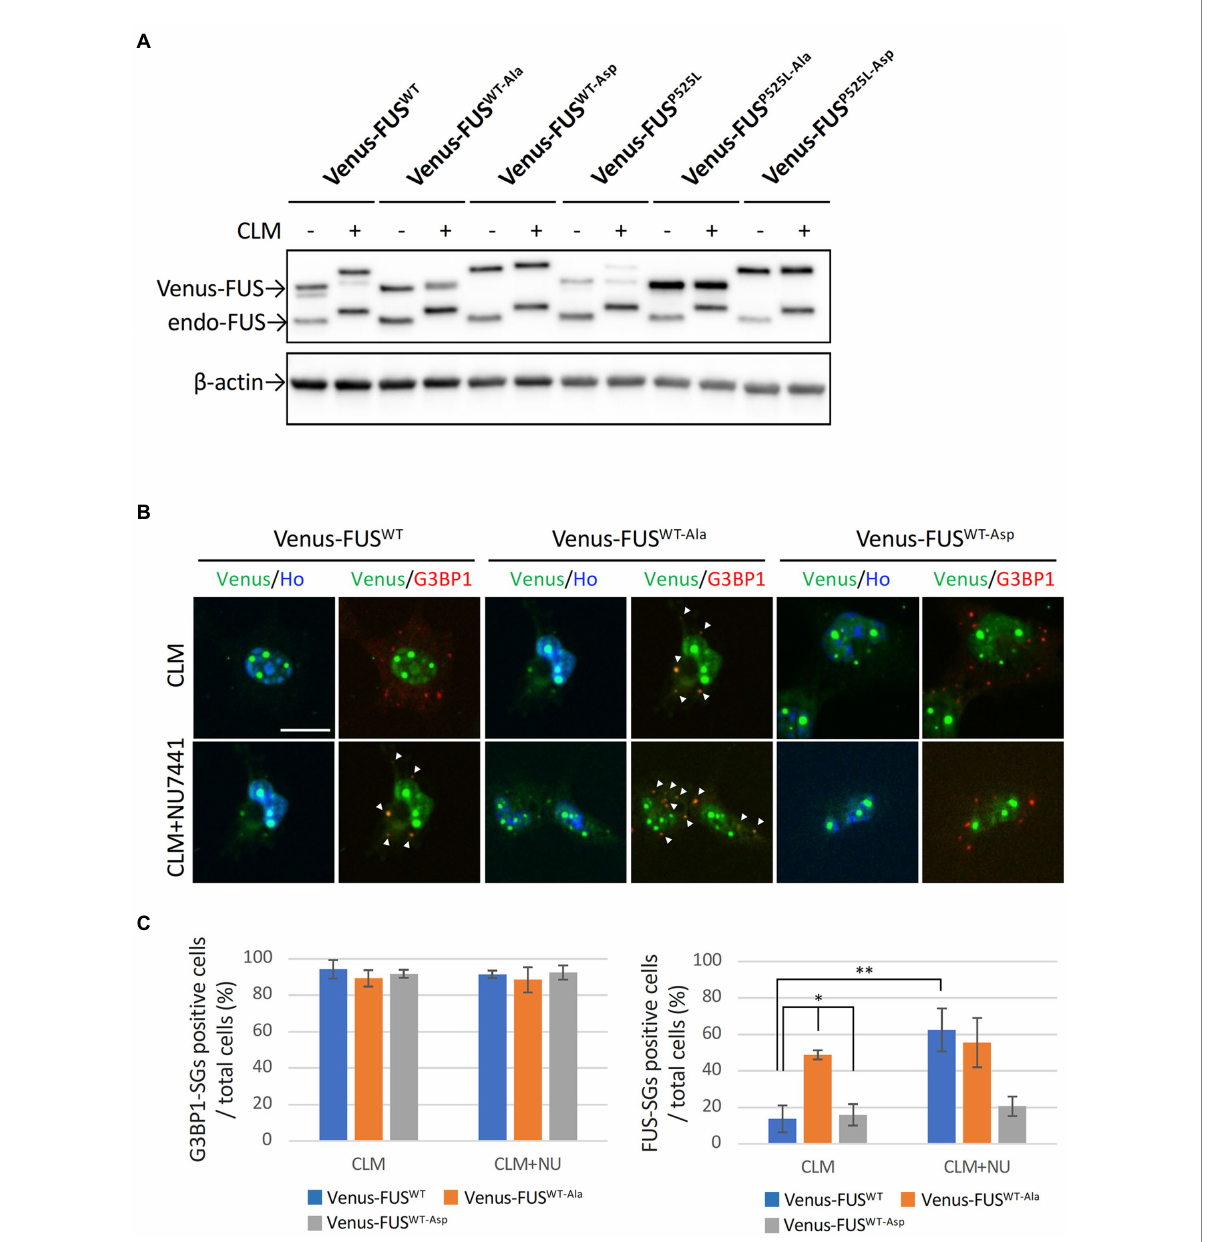
FIGURE 3 Effect of replacing 12 S/TQ residues with AQ or DQ residues in the N-terminal region of wild-type and mutant FUS proteins. (A) U251 MG (KO) cells stably overexpressing Venus-FUS WT-Ala , Venus-FUS WT-Asp , Venus-FUS P525L-Ala, and Venus-FUS P525L-Asp were cloned, and Western blotting with an anti- FUS antibody was performed to confirm the expression of Venus-tagged FUS and endogenous FUS proteins in each cell line from three biological replicates. Cells were treated with 100 nM CLM for 5 h. An anti- β -actin antibody was used as a control. (B) The subcellular distribution of Venus- FUS WT , Venus-FUS WT-Ala and Venus-FUS WT-Asp (Green) co-stained with G3BP1 (Red), a marker for SGs and Hoechst (Blue), a marker for nuclei was observed in cells by fluorescence microscopy. Cells were treated with 1 μ M NU7441 for 1 h and were then treated with 100 nM CLM for 5 h in the presence of 1 μ M NU7441 or DMSO (control). Arrowheads indicate G3BP1 positive cytosolic SGs with Venus-FUS WT or Venus-FUS WT-Ala proteins. Scale bar: 20 μ m. (C) Quantitative data of the ratio of G3BP1-SGs-positive cells (Left) and FUS-positive SGs (Right) in total cells (at least 3 biological replicates; mean ± SD; * p < 0.001; Dunnett’s test and ** p < 0.001 t